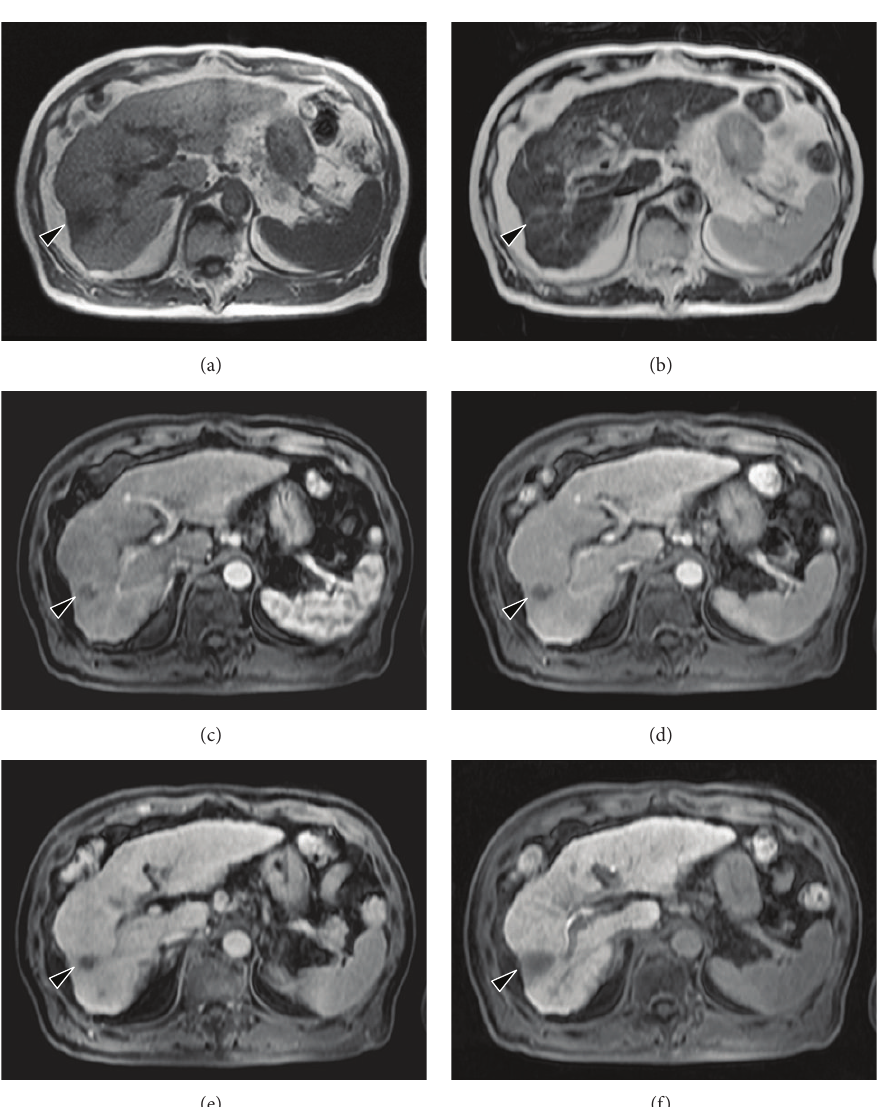
Figure 6: MR images obtained approximately four months after transcatheter arterial chemoembolization and radiofrequency ablation. (a) A hypodense area 1.5cm in diameter is observed on T1-weighted image. (b) A hyperdense area is found on T2-weighted image. ((c)–(f)) Gadolinium ethoxybenzyl diethylenetriamine pentaacetic acid-enhanced images. In the arterial phase following contrast injection (c), the center of the tumor is enhanced intensely and homogeneously. In the delayed phase (d) and hepatobiliary phase (f), the tumor is completely washed out. e: portal phase. The tumor size has diminished compared to Figure